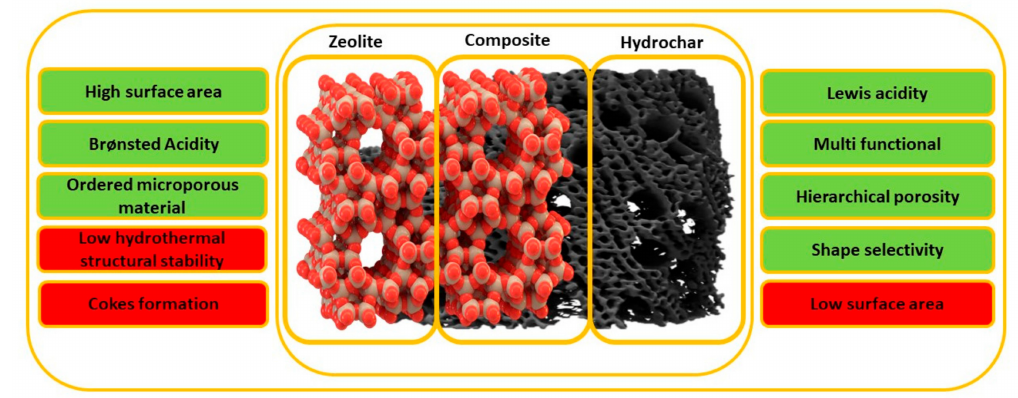
Figure 5. Advantages and disadvantages of zeolite and hydrochar catalysts.